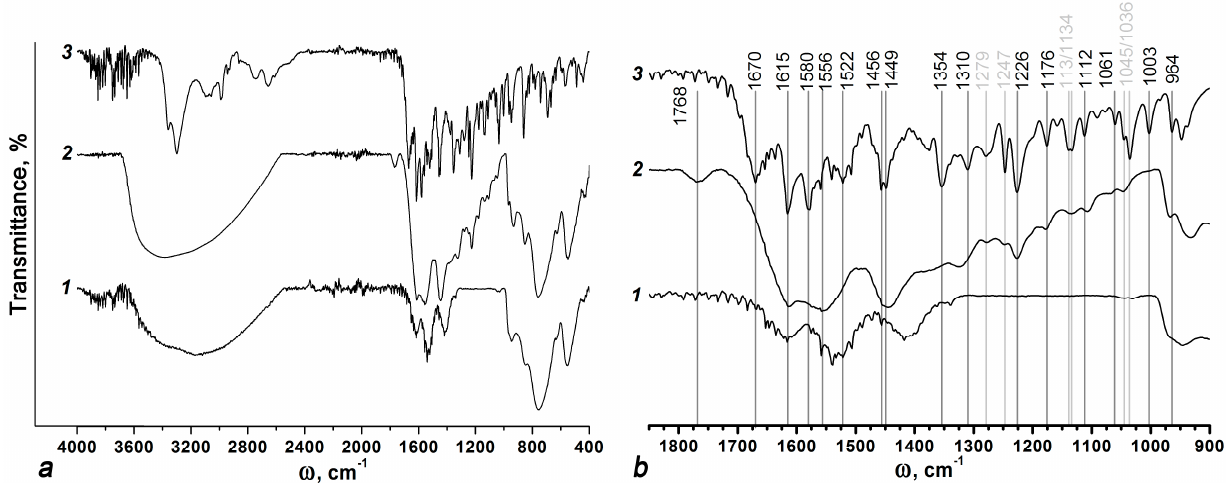
Figure 2. IR-spectra (ATR mode) of {Mo 72 Fe 30 }, {Mo 72 Fe 30 }@ ТС 12.5 and ТС∙ HCl (from bottom to top 1, 2, 3, respectively) in the full spectral range ( a ) and in the specific range ( b